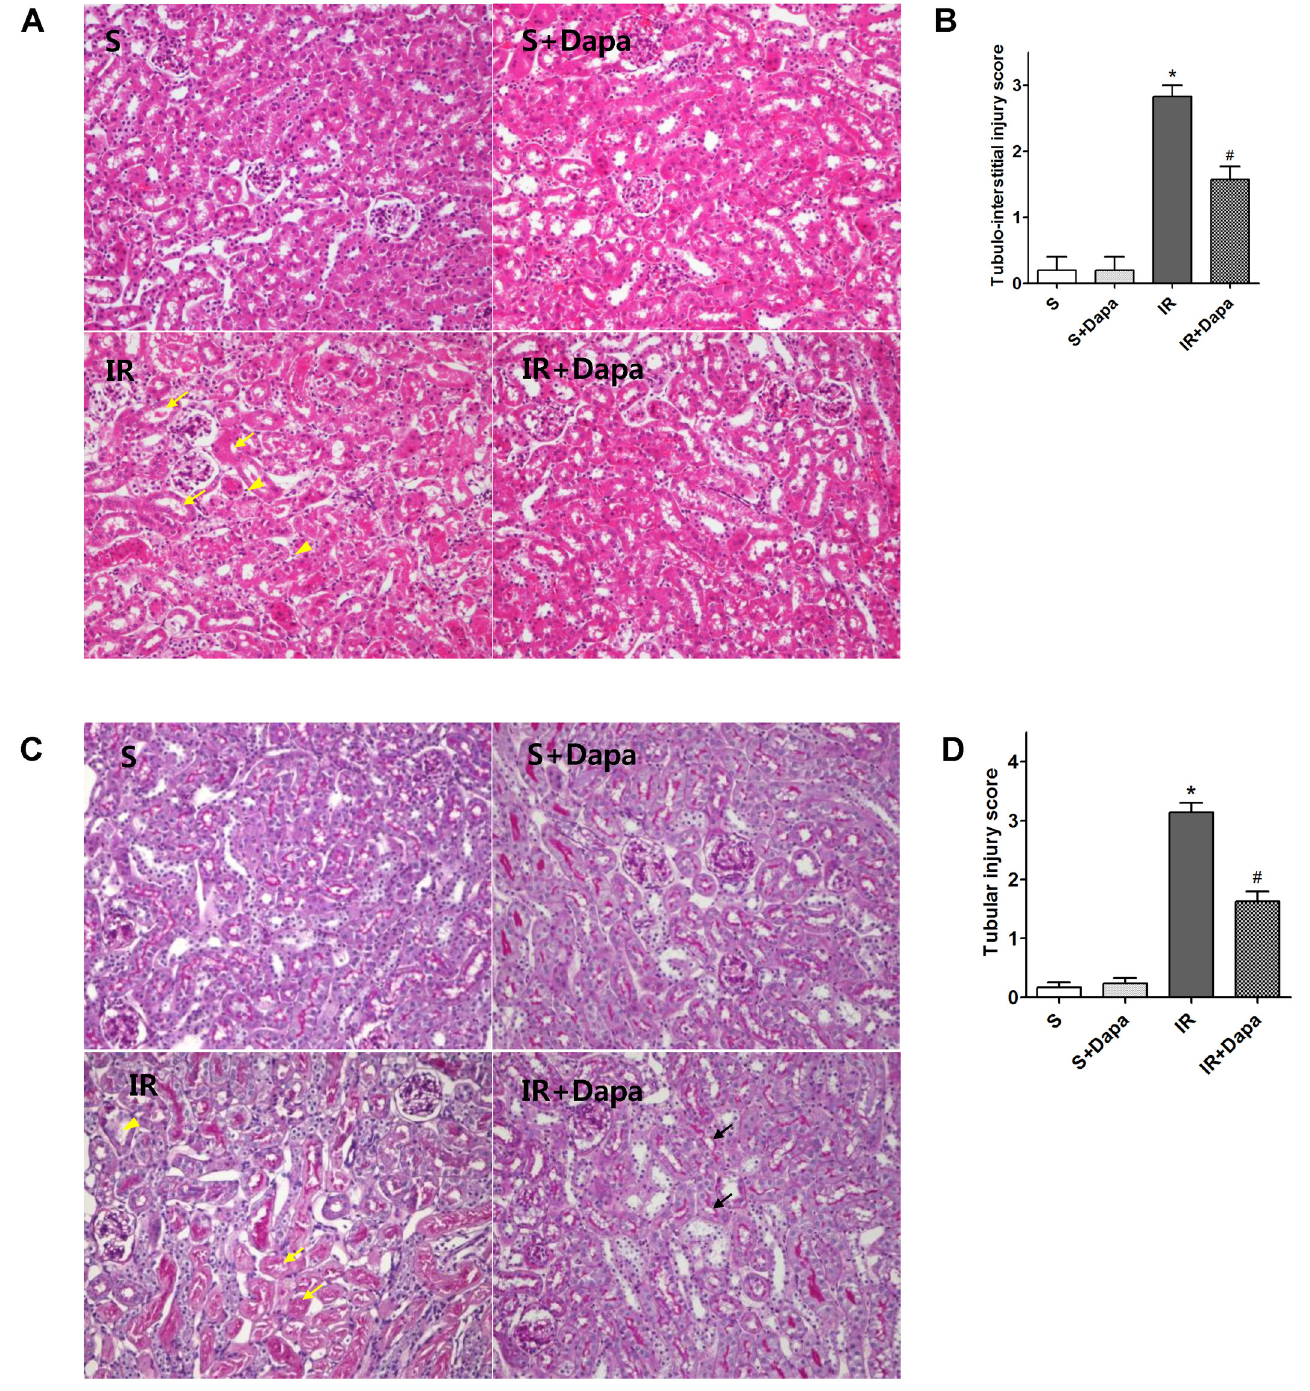
Fig 2. Representative kidney section stained for hematoxylin and eosin (H&E) and periodic acid-Schiff (PAS). (S(n = 5); S + Dapa (n = 5), IR (n = 7), IR + Dapa (n = 7)). (A) H&E stain, yellow arrows indicate cell debri and tubular necrosis. Yellow arrowheads indicate inflammatory cells. Original magnification, 200×. (B) Semi-quantitative analysis of tubule interstitial injury in wild-type and dapagliflozin- and/or albendazole-treated mice 24 h after renal IR injury (C) PAS stain. Yellow arrows indicate necrotized tubules or cast formation. Yellow arrowheads indicate loss of brush border or dilated tubules. Black arrow indicates brush border. Original magnification, 200×. (D) Semi-quantitative analysis of tubular injury in wild-type and dapagliflozin- and/or albendazole-treated mice 24 h after renal IR injury. * P < 0.05 vs. vehicle-treated sham, # P < 0.05 vs. vehicle-treated IR. Bar represents mean ± s.d.